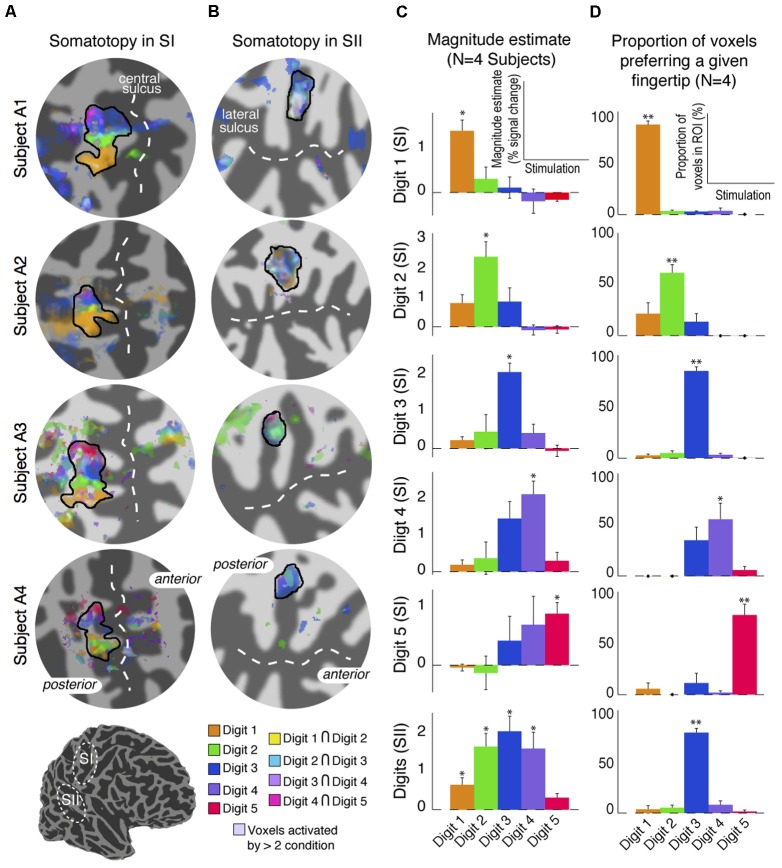
Results from the digit mapping GLM analysis. (A) Superposition of digit activation maps (threshold at P < 0.01, FDR-corrected) displayed on a flattened cortical patch of the central sulcus. Voxels activated by the stimulation of adjacent digits are shown in intermediate colours (see colour legend). (B) Superposition of digit activation maps on a flattened cortical patch of the lateral sulcus showing overlap of activation in SII. Voxels activated by more than two digits are shown in de-saturated (whiter) shades. (C) Parameter estimates of the magnitude component from the canonical HRF GLM fit for each stimulation condition averaged across voxels, and across four subjects, in each of the digit-specific SI ROIs and the SII ROI. Error bars represent standard error across subjects. ∗p < 0.05, statistical significance of each parameter estimate compared with 0. (D) Proportion of voxels in each of the SI digit-specific and SII ROI responding maximally in either of the five-digit stimulation conditions. Error bars represent standard error across subjects. ∗∗p < 0.01, statistical significance of each proportion compared with 0.